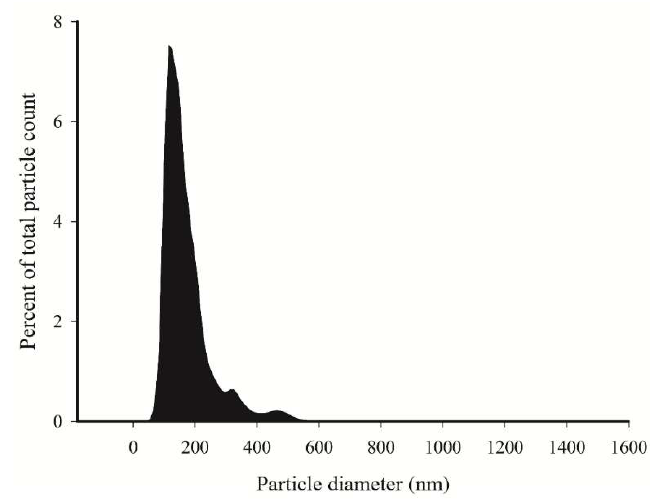
Figure 2. The size distribution of nano-sized particles in the 5 μm-filtered conditioned media of fibroblast-like synoviocytes ( n = 5) determined by nanoparticle tracking analysis.